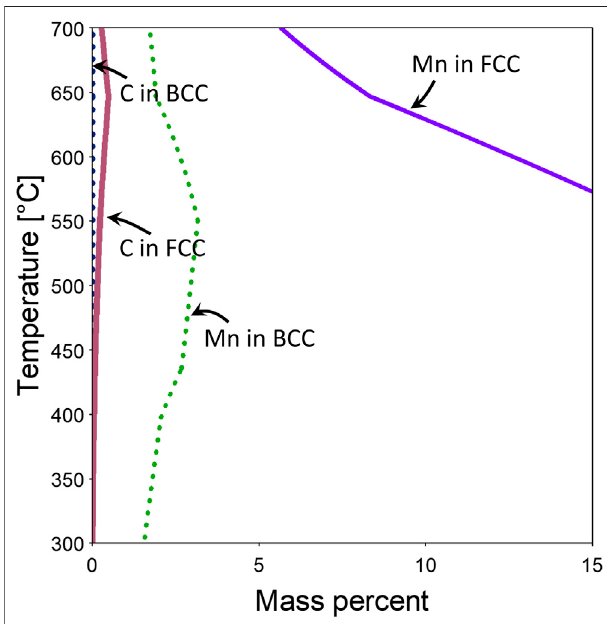
FIGURE 8 | Equilibrium predictions of compositions (mass percent) of selected elements in austenite (FCC A1) and Ferrite/martensite (BCC A2) based on